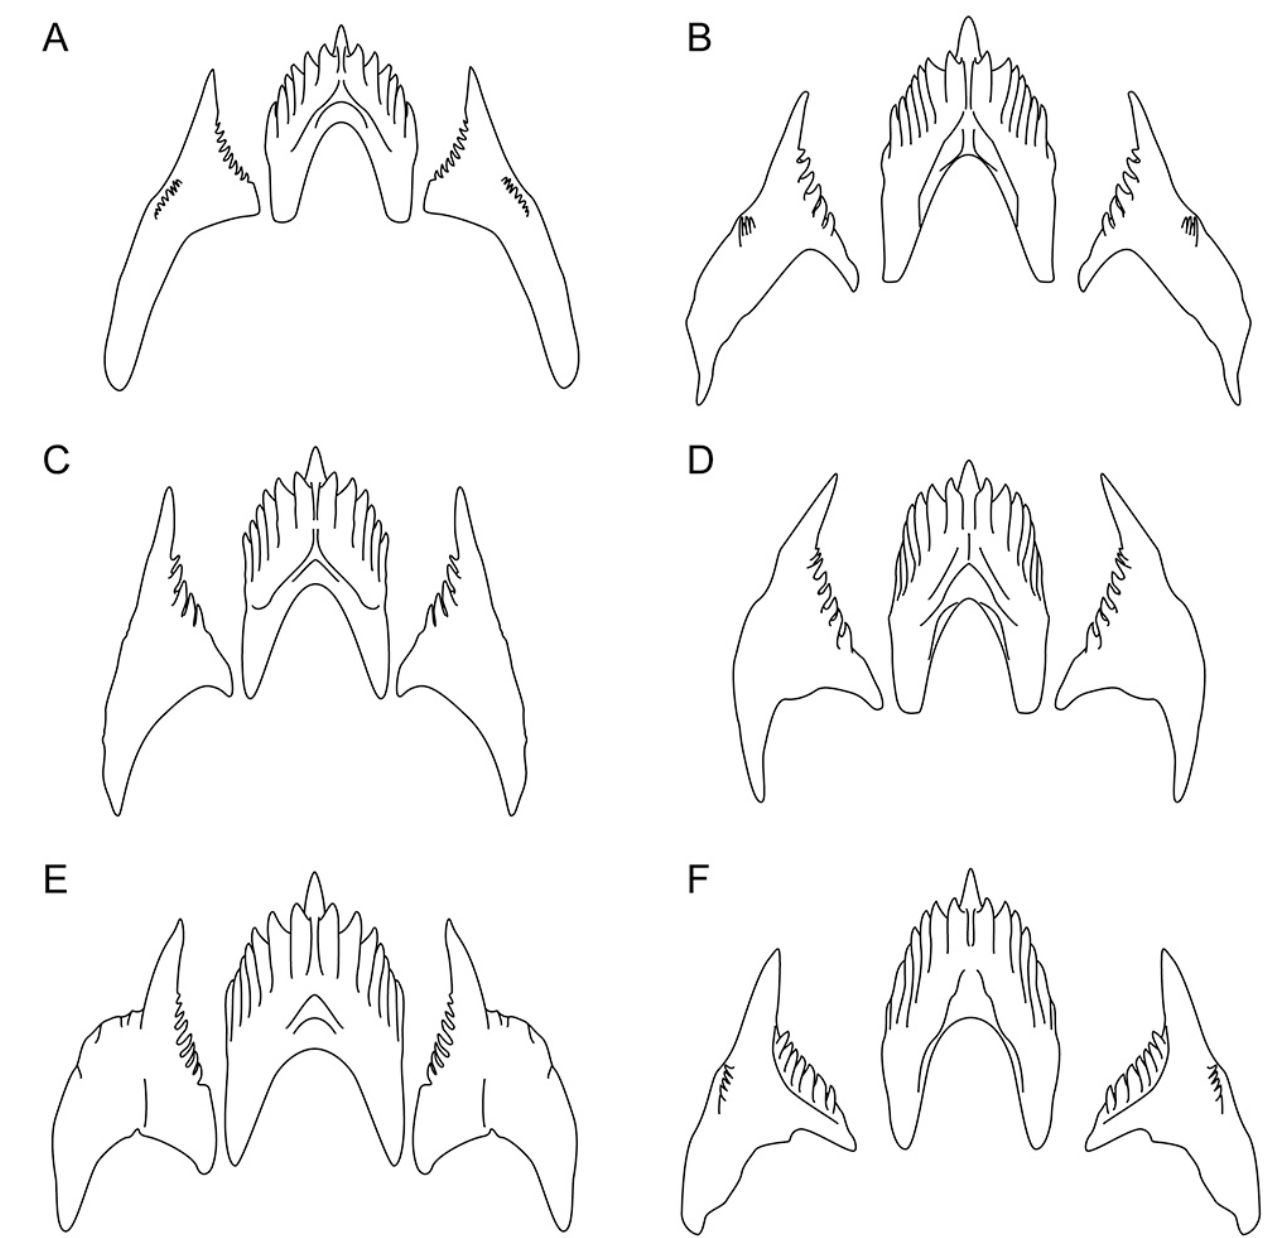
Figure 6. Diagrams of transverse radular row within Coryphellina rubrolineata species complex. ( A )— Coryphellina rubrolineata . ( B )— Coryphellina lotos . ( C )— Coryphellina pseudolotos sp. nov. ( D )— Coryphellina pannae sp. nov. ( E )— Coryphellina flamma sp. nov. ( F )— Coryphellina aurora sp. nov.